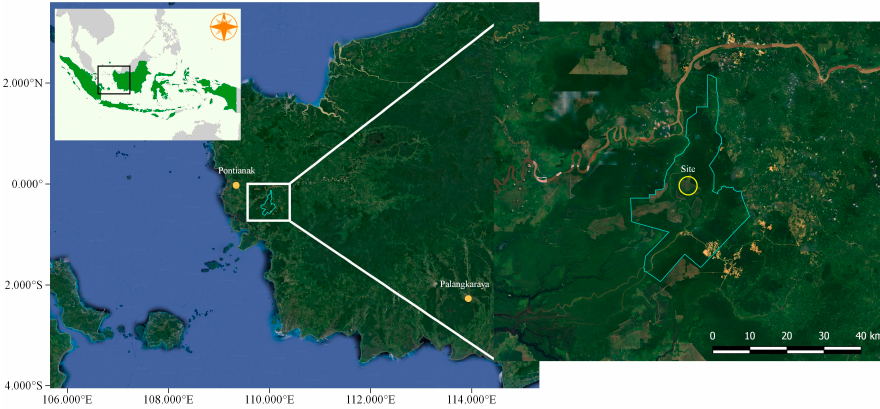
Figure 2. Location of the study site at West Kalimantan.